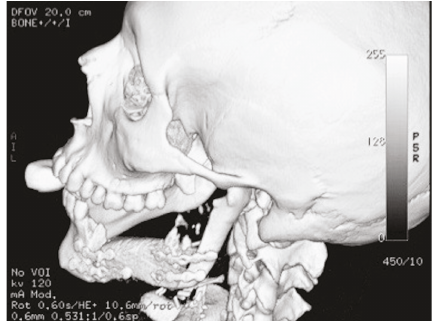
Figure 2: Radiographic image after reconstruction by FRF.